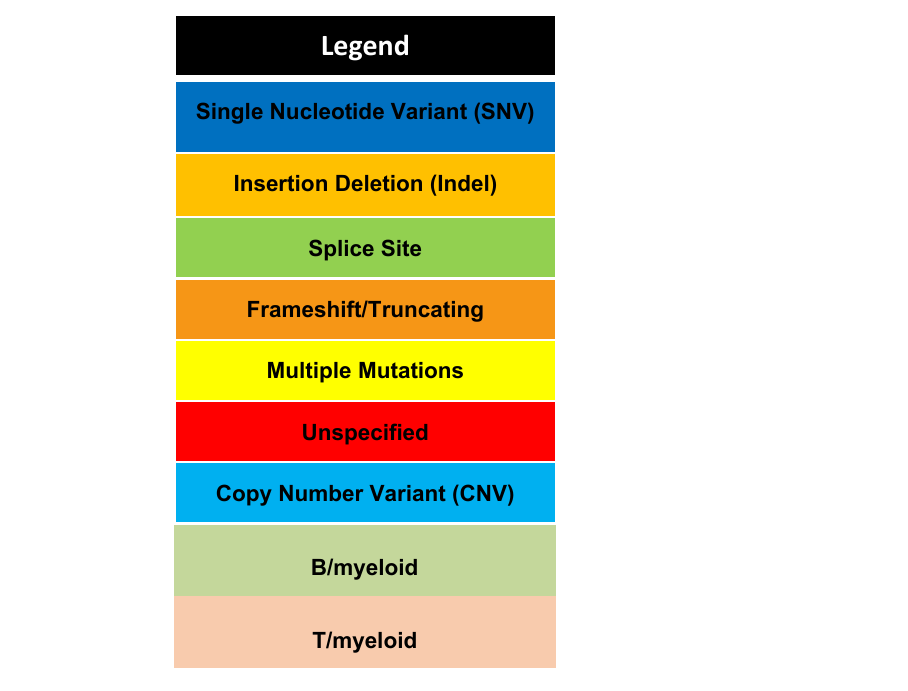
Figure 3. Genomic landscape of mixed-phenotype acute leukemia (MPAL).